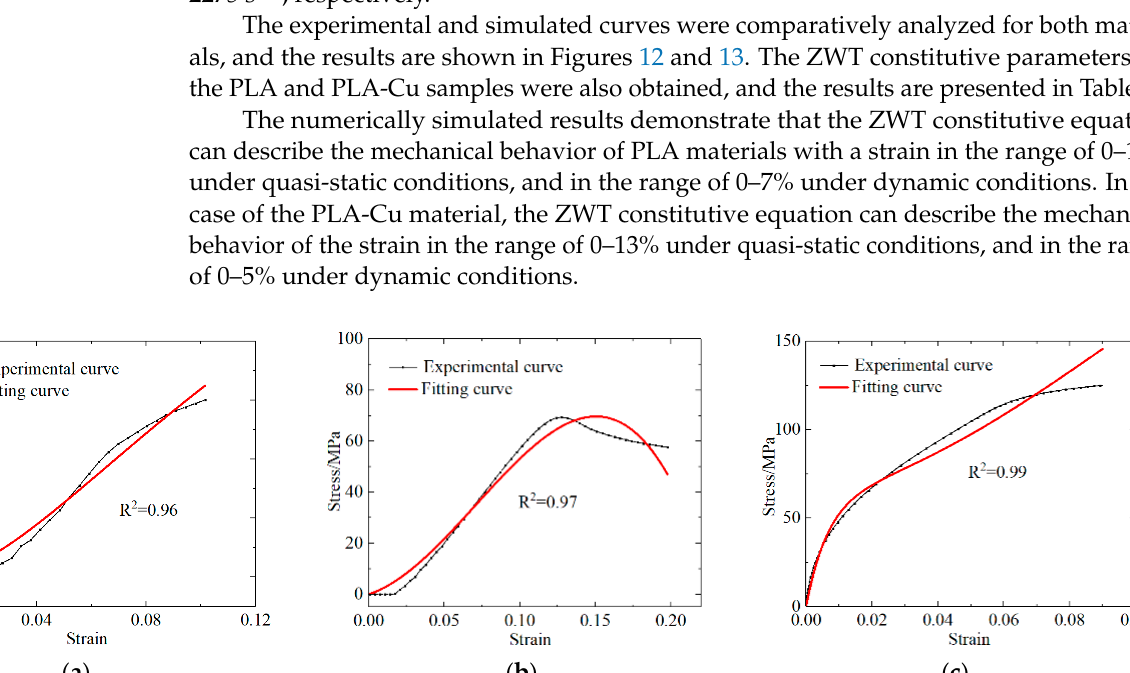
( c ) Figure 13. Comparison of PLA ‐ Cu experimental curve and fitting curve. ( a ) Low strain rate stress difference; ( b ) low strain rate; ( c ) high strain rate.